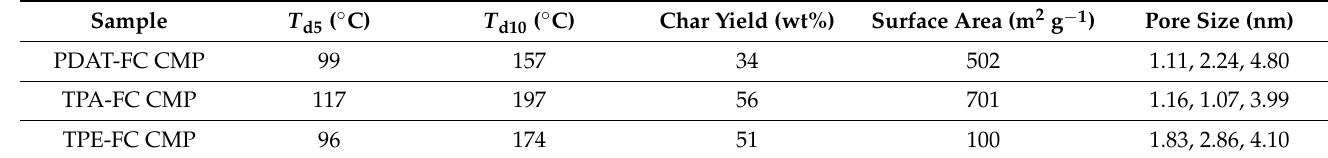
Table 1. TGA and pore parameters data for PDAT-FC, TPA-FC, and TPE-FC CMPs.